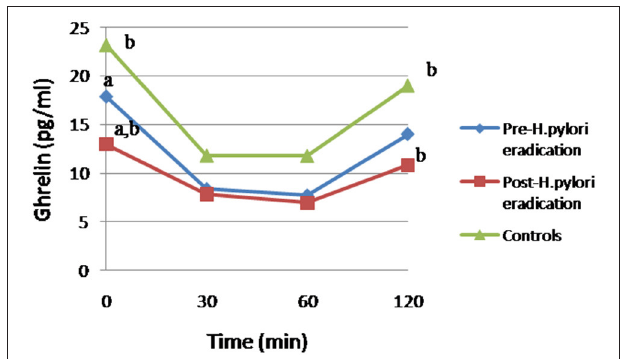
FIGURE 1 | Changes in ghrelin levels after 75g-OGTT in patients and controls. Equal letter means differences between groups. (a) Differences between H. pylori -infected individuals before and after antibiotic treatment, p < 0.05. (b) Differences in patients undergoing antibiotic therapy compared to the control group, p <